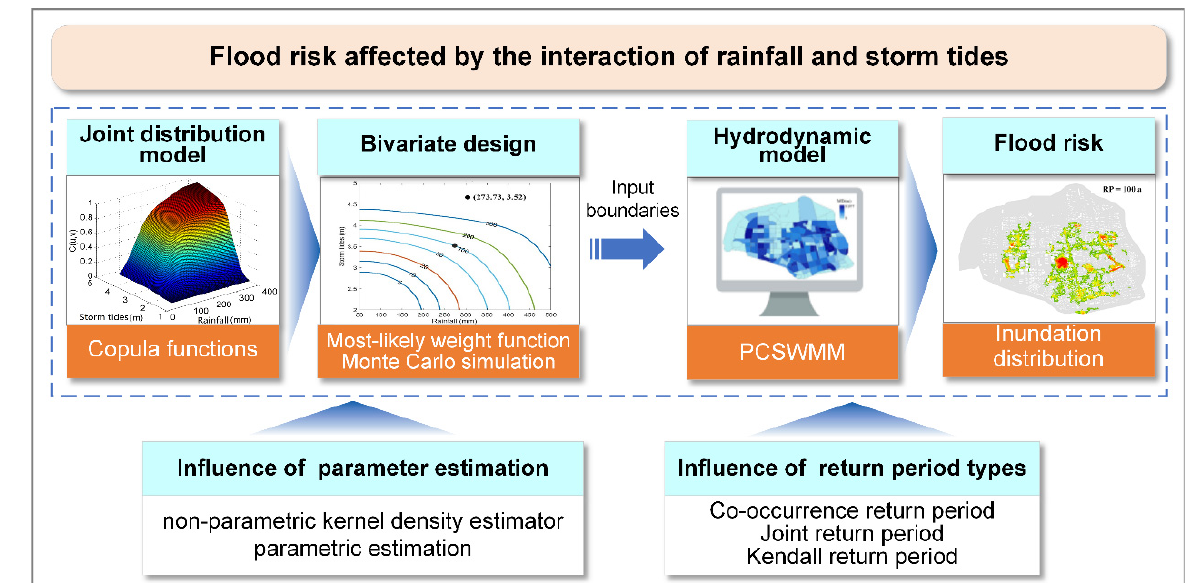
Figure 1. The research framework of the study.